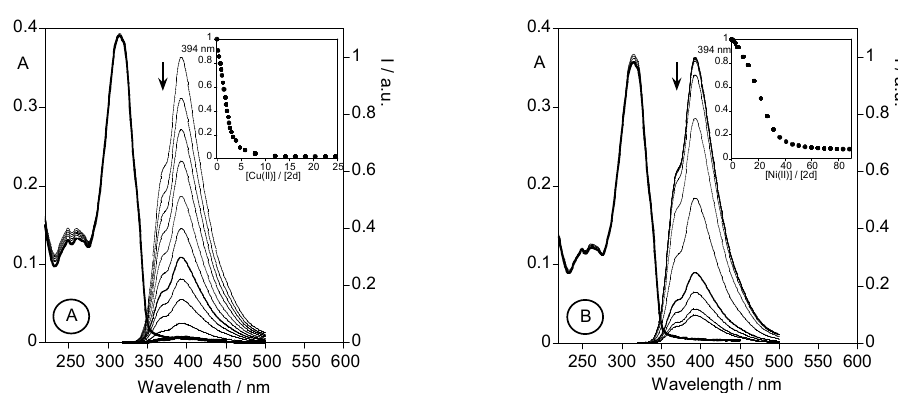
Figure 6. Spectrophotometric titration and fluorimetric titration of an ethanolic solution of 2d with a standard solution of Cu(CF SO ) (A) and Ni(BF ) (B) in absolute ethanol. ([ 2d ] = 1.80E-5 M, T = 3 2 2 4 2 298 K, λ = 315 nm. Insets: normalized emission at 394 nm in both cases). exc